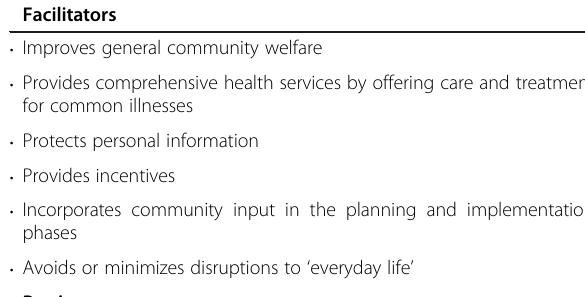
their communities would view as facilitators and